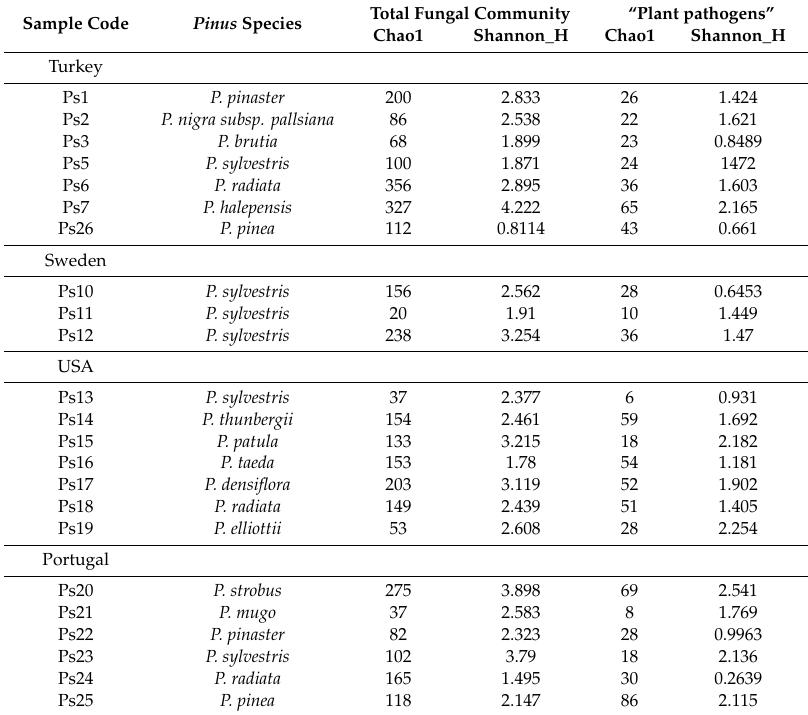
Table 2. Shannon index (H) and Chao1 richness of the total fungal community associated with seed samples of Pinus species from di ff erent countries.